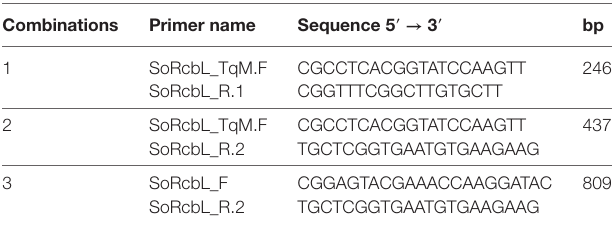
TaBle 3 | Primers name, primers sequences, and expected size of amplified